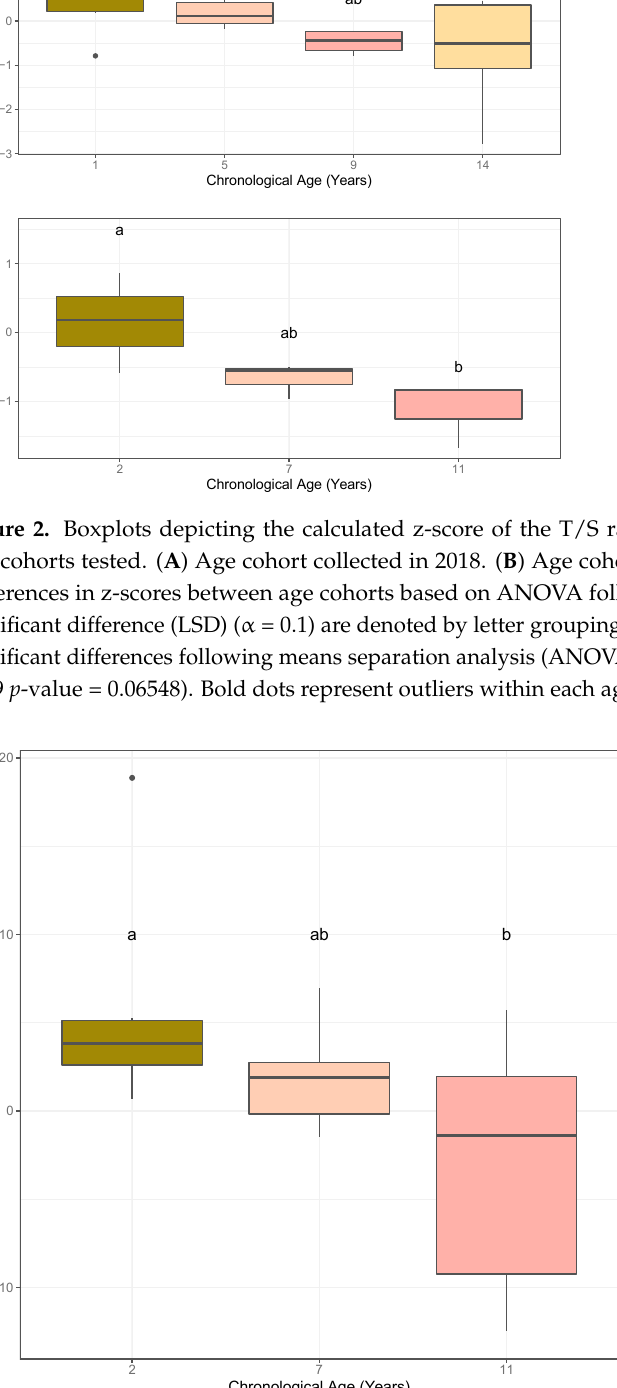
Figure 3. Boxplot depicting calculated z-score for the T/S ratio for bud samples within the age cohorts collected in 2019. Significant differences in z-scores between ages cohorts based on ANOVA followed by post hoc Fisher’s LSD ( α = 0.05) are denoted by letter groupings where differing letters indicate significant differences following means separation analysis (ANOVA p -value = 0.067). Bold dots represent outliers within each age